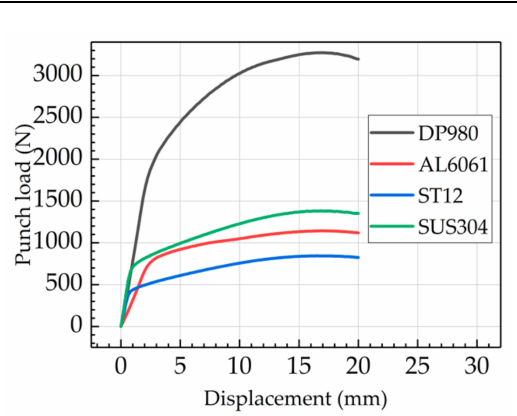
Figure 14. Curve of bending force stroke of experimental material.